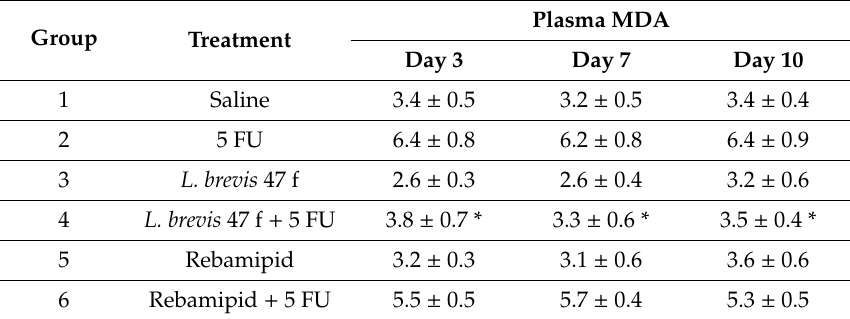
Table 5. Time course of MDA levels in the male